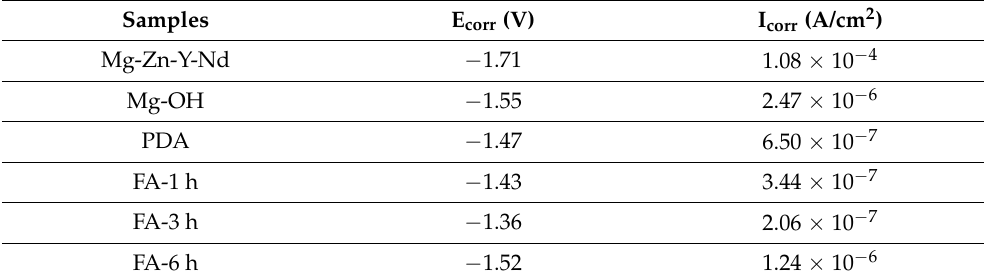
Table 1. Corrosion potential (Ecorr) and current density (Icorr) of samples.